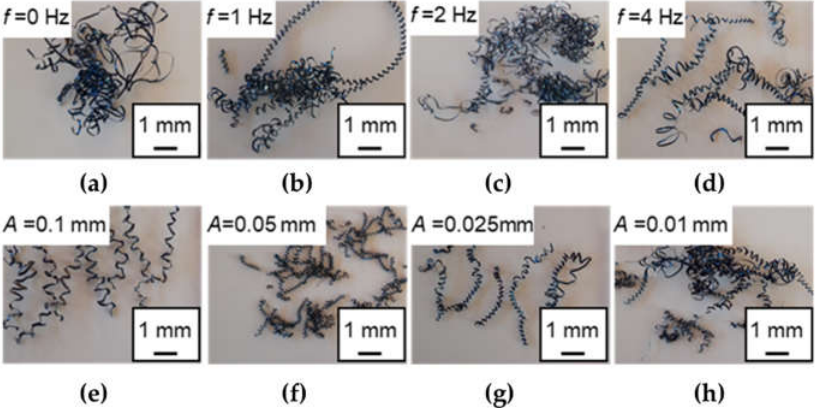
Figure 13. Observation of the generated chip on LFAB processes with vibrational conditions A = 0.1 mm and frequency ( a ) f = 0, ( b ) f = 1, ( c ) f = 2 and ( d ) f = 4 Hz, tests 23–26 of Table 2, and with constant f = 4 Hz and different amplitudes ( e ) A = 0.1, ( f ) A = 0.05, ( g ) A = 0.025 and ( h ) A = 0.01 mm; tests 19– 22 of Table 2.